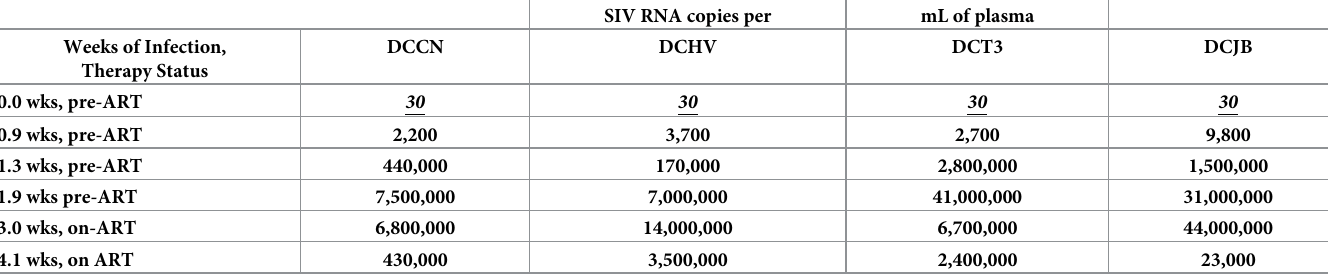
Table 6. Levels of SIV RNA in samples taken from infected